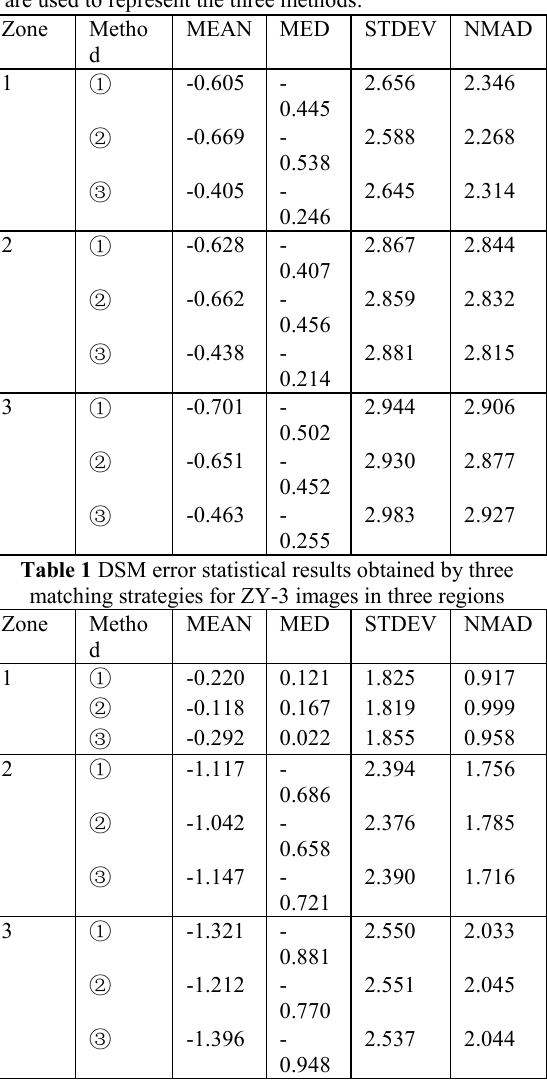
Table 2 DSM error statistical results of Pleiades images in three regions obtained by three matching